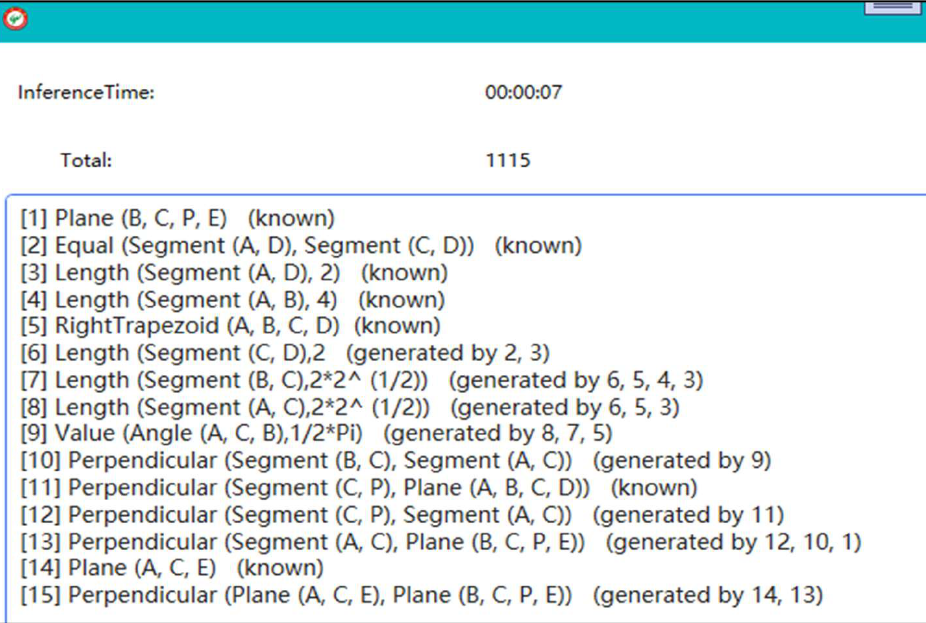
Figure 11. Results of second reasoning.